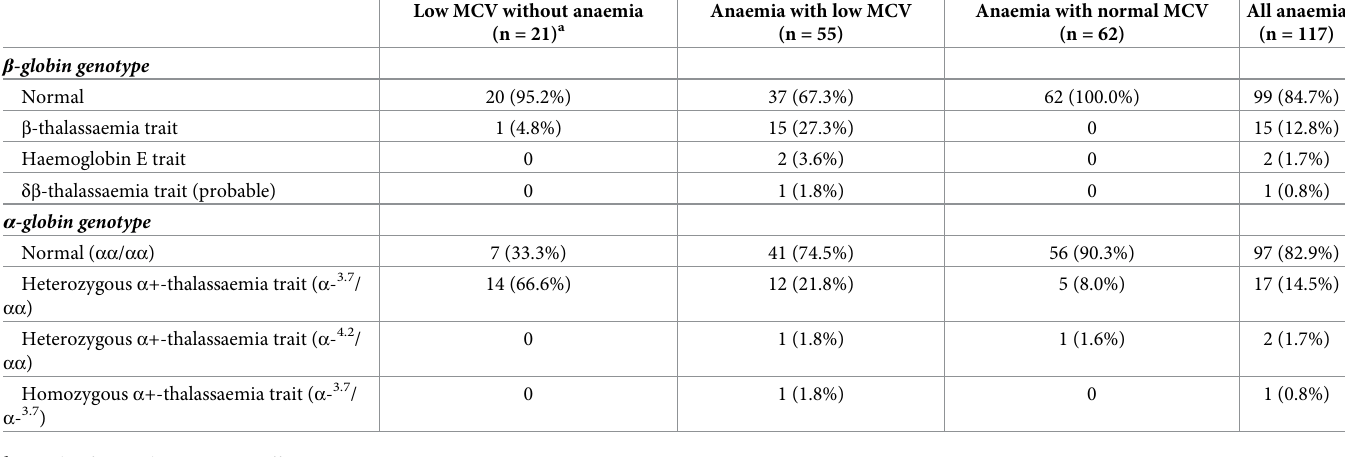
Table 3. Frequency of haemoglobinopathy among women with anaemia and/or low